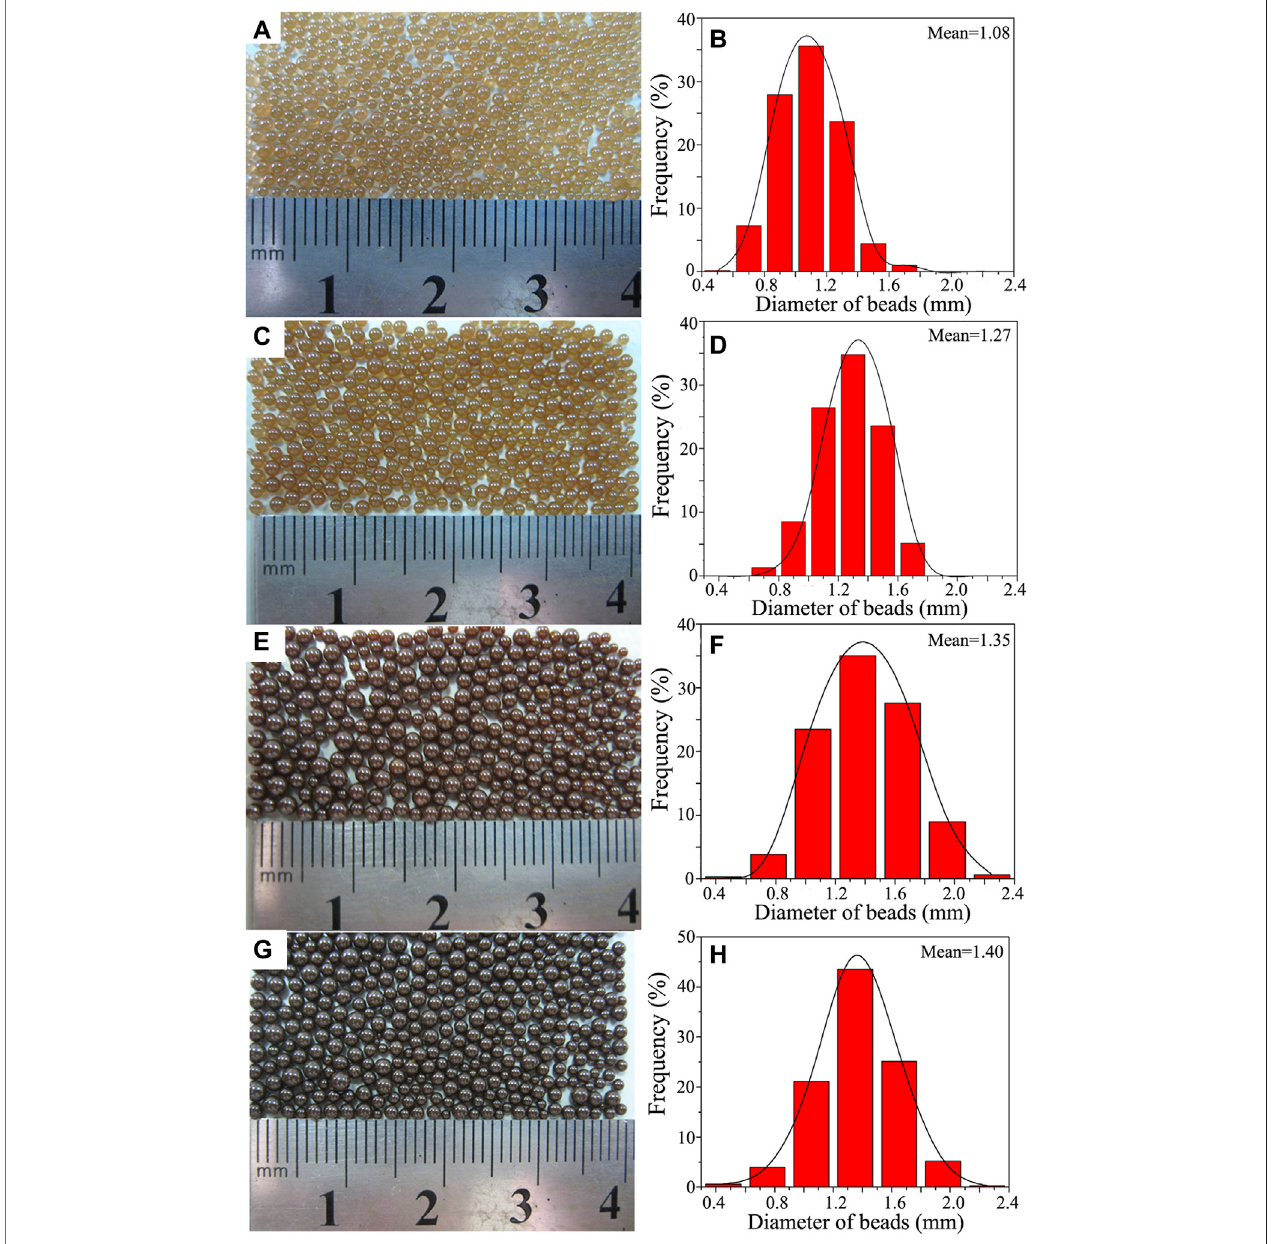
FIGURE 5 | Optical photography showing the macromorphology of PS/Fe 3 O 4 composite beads obtained with different contents of OA-Fe 3 O 4 : (A) 0.4 wt%, (C) 0.8 wt%, (E) 1.2 wt%, and (G) 1.6 wt%. Panels (B) , (D) , (F), and (H) are the statistical histograms showing the size distribution of panels (A) , (C) , (E), and (G) ,